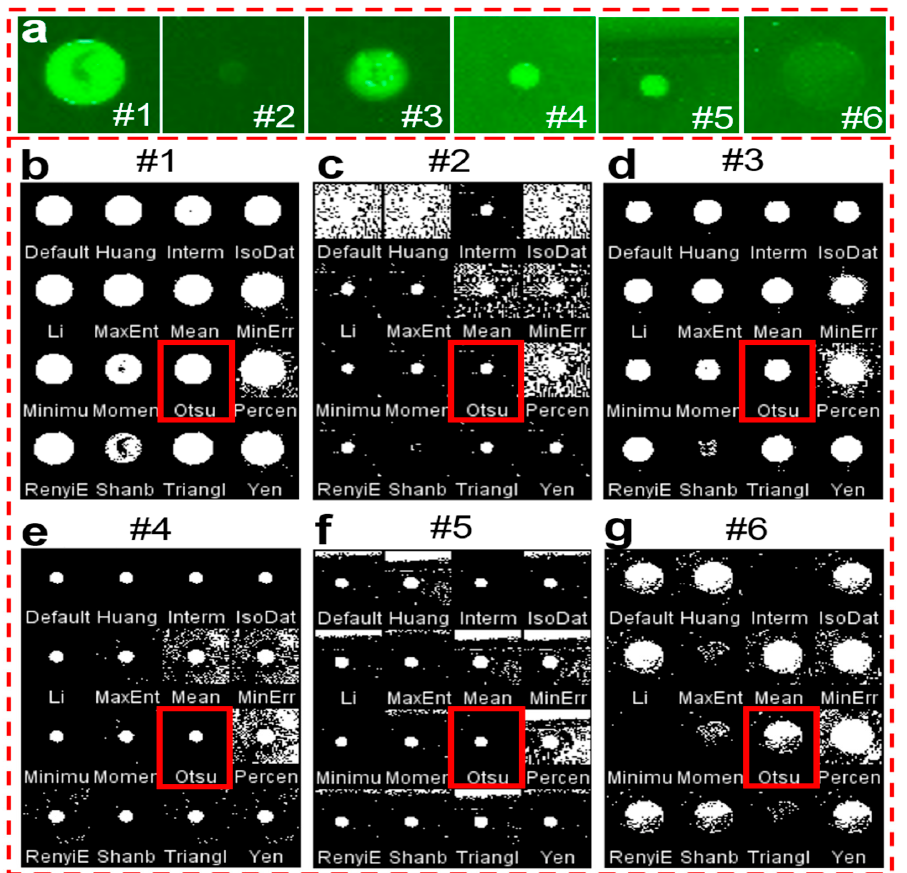
Figure 3. Comparison of the binary images obtained with various thresholding methods. ( a ) 6 typical fluorescent spots with different sizes, intensities, and background. ( b – g ) The corresponding binary images of 6 fluorescent spots after 16 thresholding methods. The red rectangles indicate the results of the Otsu thresholding method.